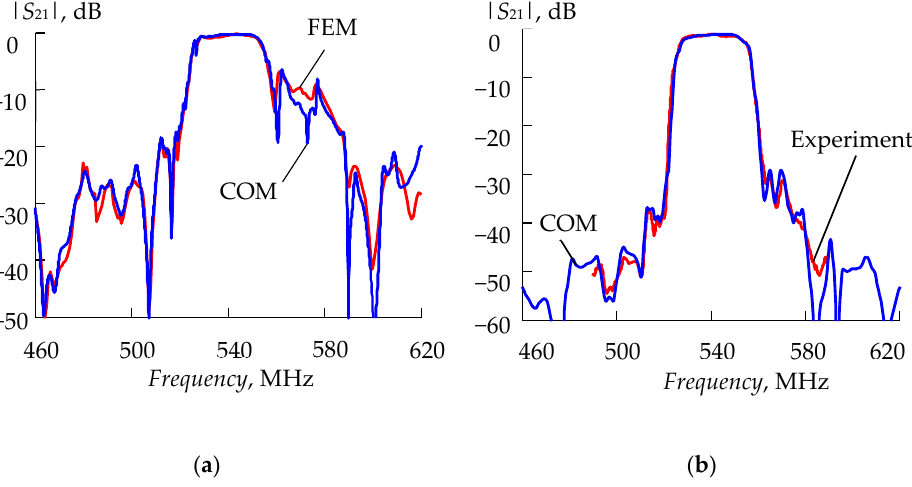
Figure 7. Frequency response: ( a ) calculated by COM and FEM for one section DMS filter; ( b ) calculated by COM and experimental for two section DMS filter.